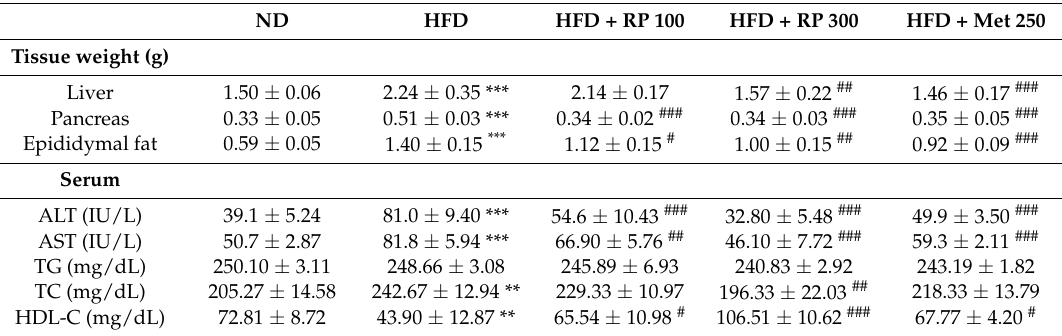
Table 1. Effect of RP extract on tissue weight and serum profiles.